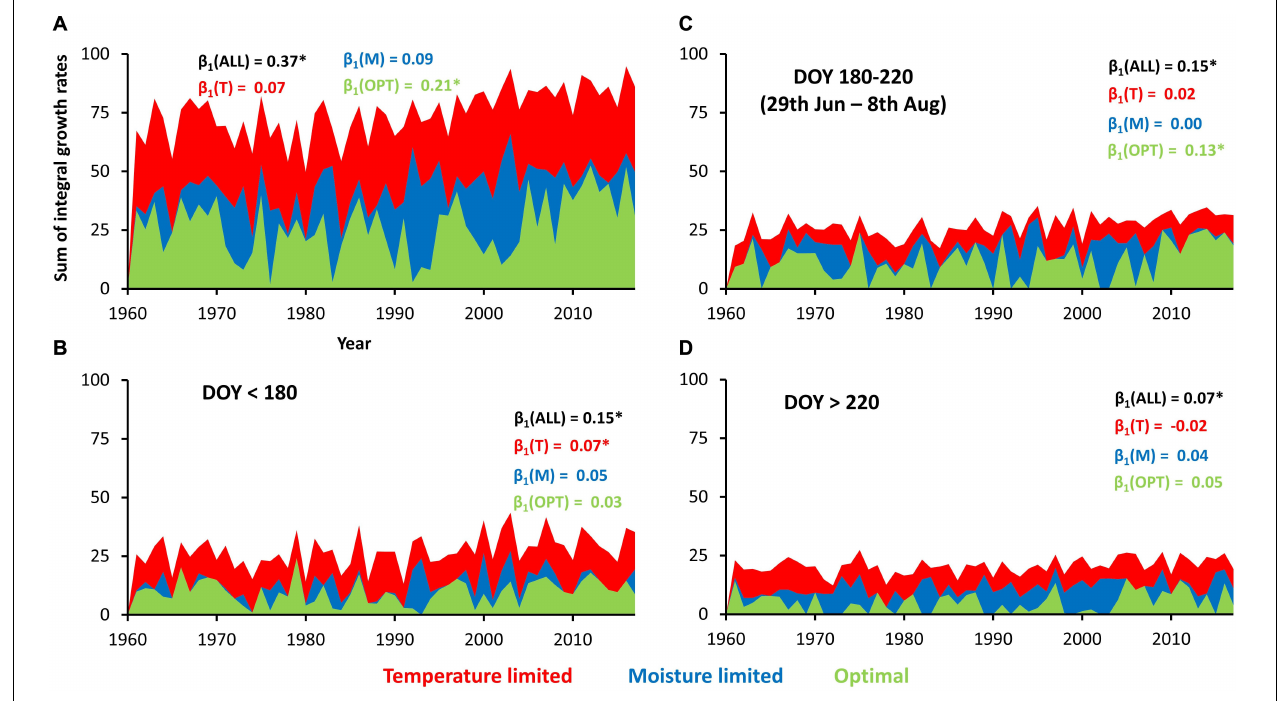
FIGURE 5 | Sum of integral growth rates under different types of climatic limitation over entire year (A) or specific parts of growing season (B–D) . β 1 indicate slopes of linear trends of integral growth rates summed during entire year (black) and during days with specific climatic limitations (colors). Asterisk indicates significant slope ( p -value <